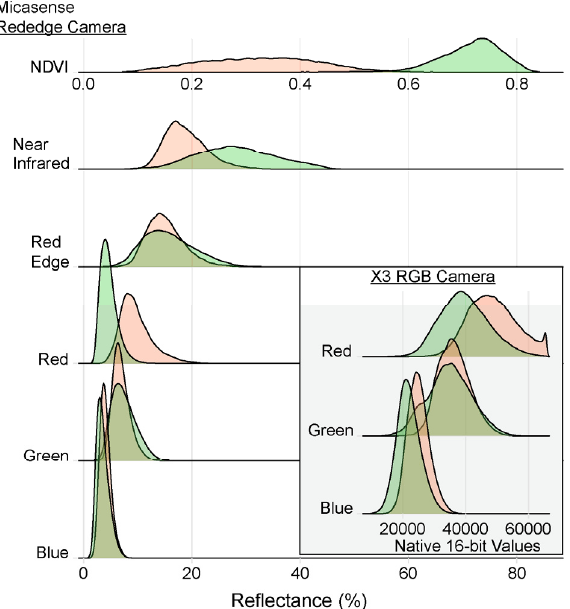
Figure 2. Comparison of density distributions of band values for points identified as scorched nee- dles (red) versus green needles (green) for the radiometric Micasense Rededge and standard RGB X3 cameras. The normalized differenced vegetation index (NDVI) was derived from the Rededge’s red and near infrared bands and used for subsequent classification of the point cloud.